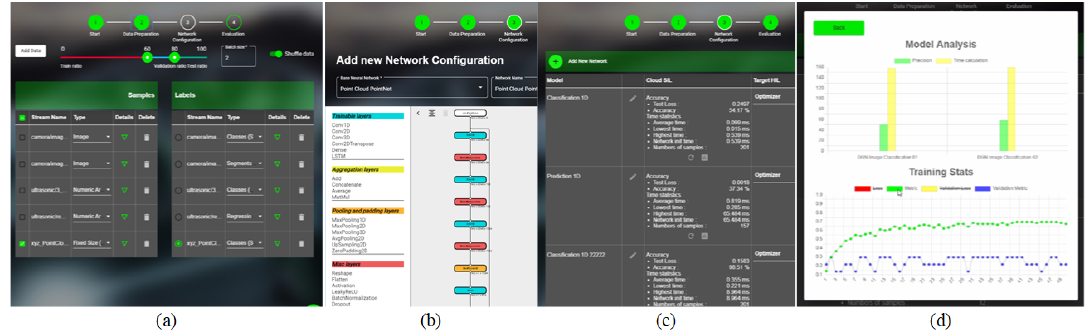
Figure 6. Snapshots from the EB-AI Cloud interface. ( a ) Data upload and pre-processing. ( b ) DNN architecture design. ( c ) Deployment and evaluation in the Cloud and Edge ECU as SiL and HiL, respectively. ( d ) Models